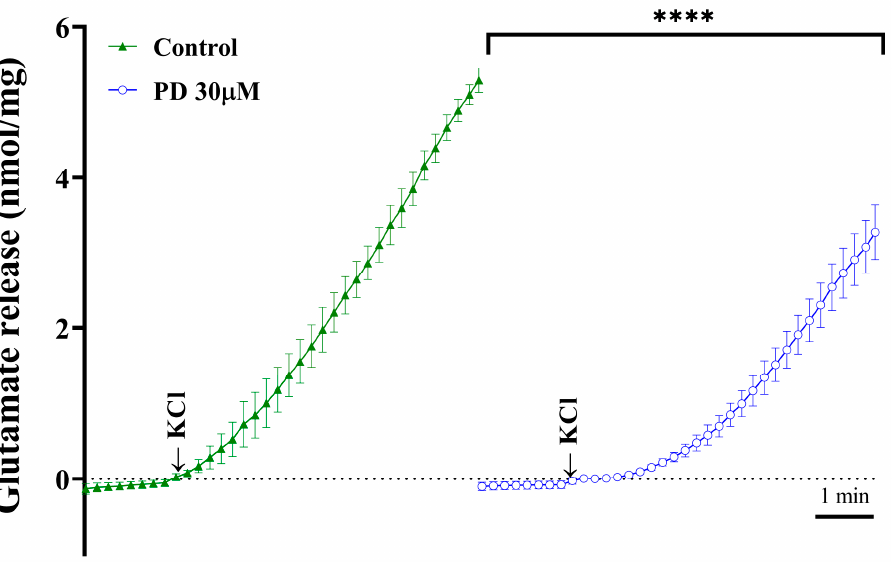
Figure 5. Effect of PD on 15 mM KCl-evoked glutamate release. The results are shown as the averages of five independent experiments, and the data represent the means ± SEMs ( n = 5 per group). **** p < 0.0001 versus the control.